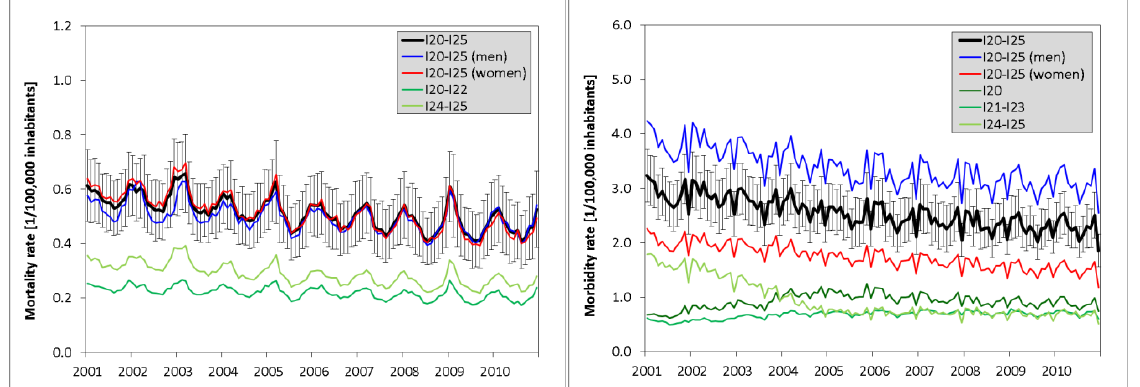
Figure 1. Monthly rates of mortality ( left ) and morbidity ( right ) per 100,000 inhabitants (averaged over all 19 regions) for ischemic diseases and its subgroups (the rates for men and women are based on 100,000 male/female inhabitants). For total ischemic diseases (I20–I25), additionally the geographical variability (calculated from the standard deviation of the 19 regions) is displayed by error